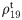
The effects of traveler risk-taking behaviors on system evolution processes.Fig 4(a) and 4(b) compare the effect difference between risk aversion and risk proneness attitudes. Fig 4(c) and 4(d) show the influences of parameter σ on both fluctuation function Θt and endogenous risk attitude ρ19t.